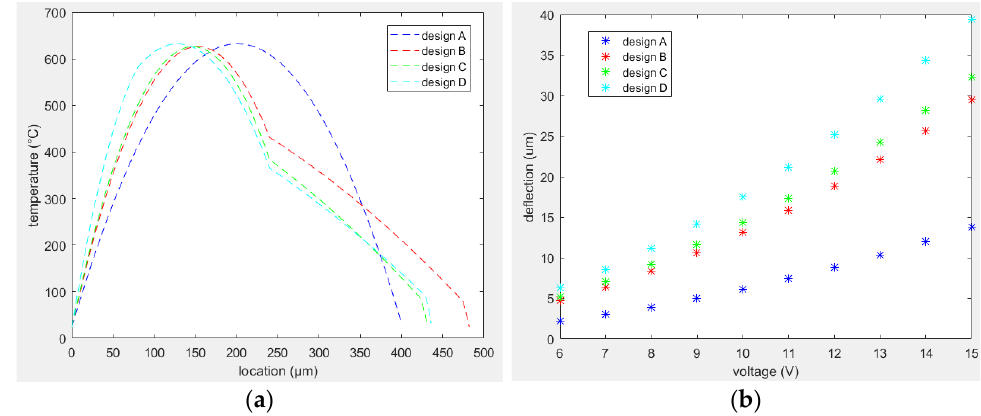
Figure 18. Performance of design D actuator compared to other designs: ( a ) temperature distribution; ( b ) tip deflection.